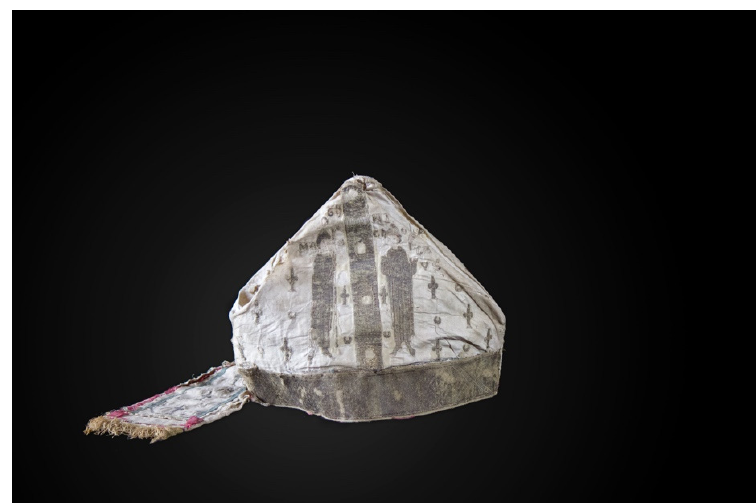
Figure 7. Anagni Mitre, front face with full-length portraits of Becket and St Nicholas. Ancient treasury of Anagni Cathedral, now in the cathedral museum, Italy. © by concession of the Chapter of the Basilica Cathedral of Anagni. Photo: Graframan.com.